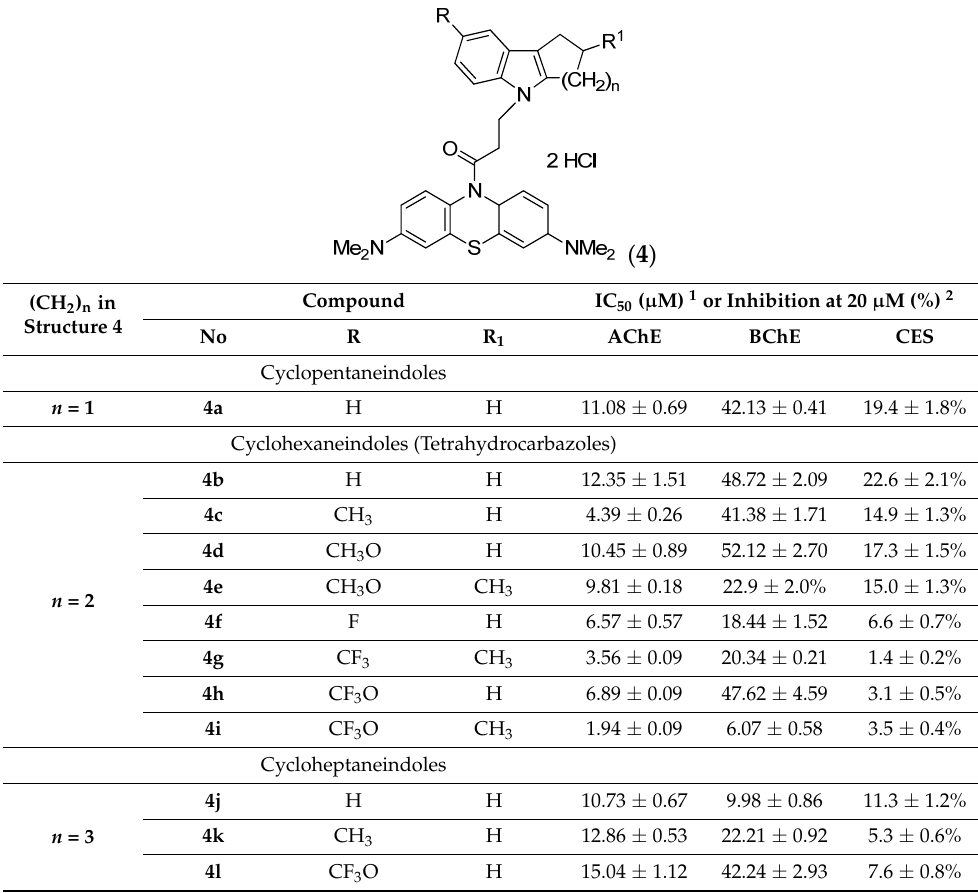
Table 1. Inhibitory activity of MB-cycloalkaneindoles conjugates 4 against AChE, BChE, and CES.